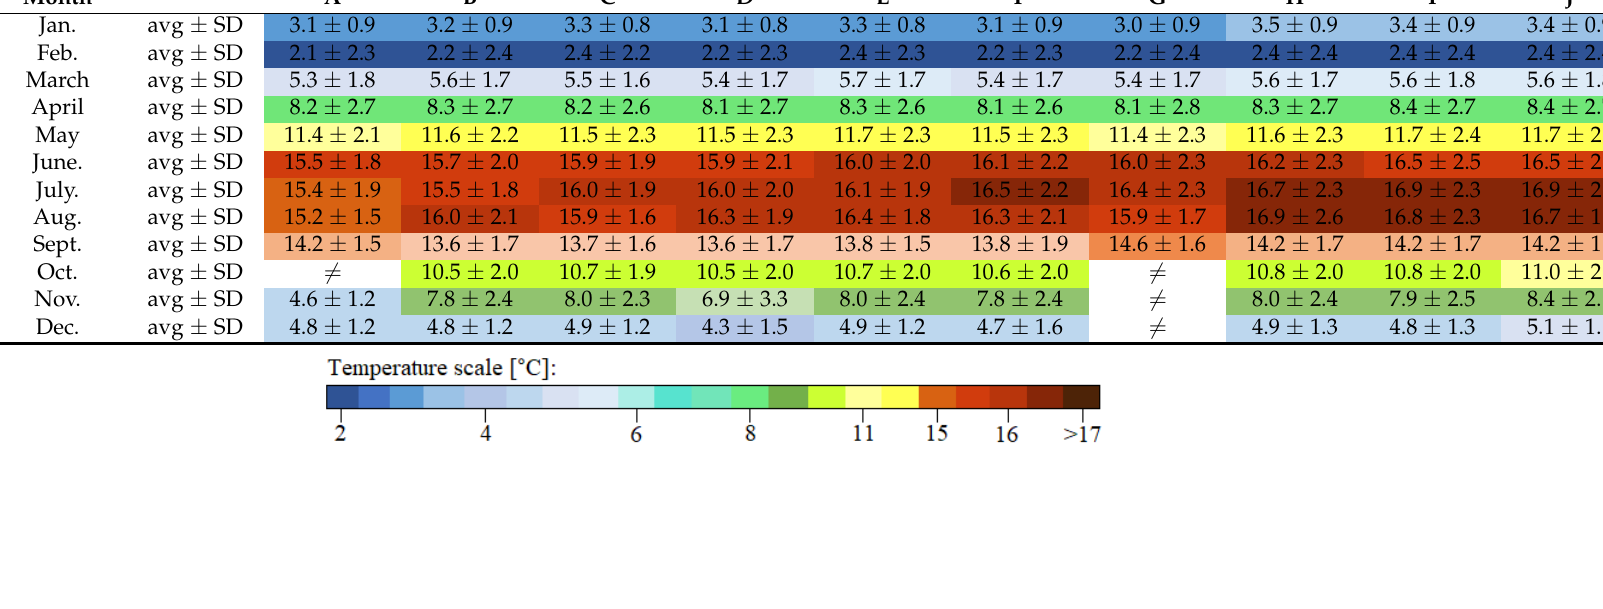
Table 3. The average temperature (±SD) of the months January to December (2020–2021) for the stations